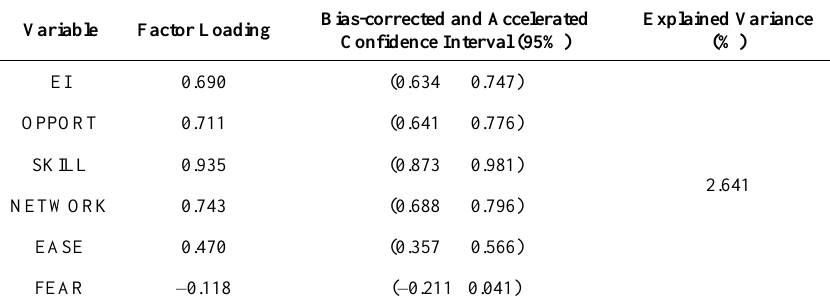
Table 5. Unidimensional Solution Based on the Tetrachoric Correlation